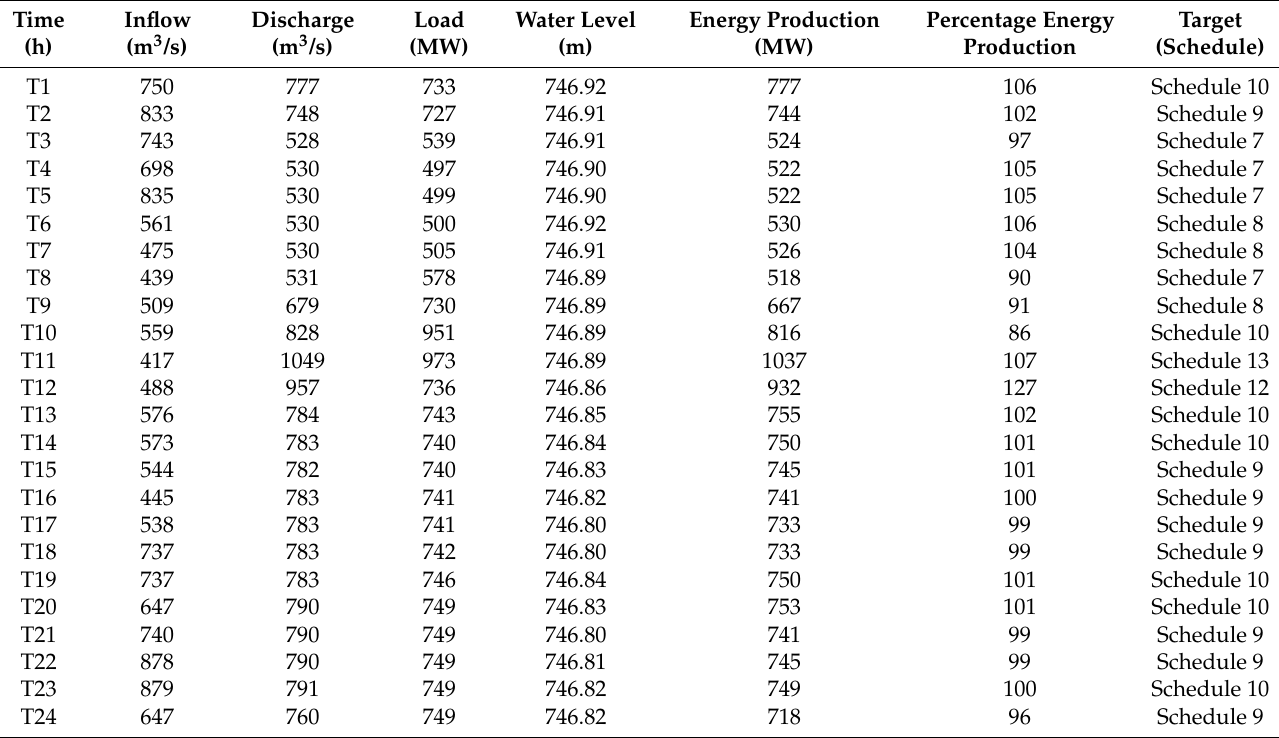
Table 2. Data set of Tianshengqiao plant 1 for the summer